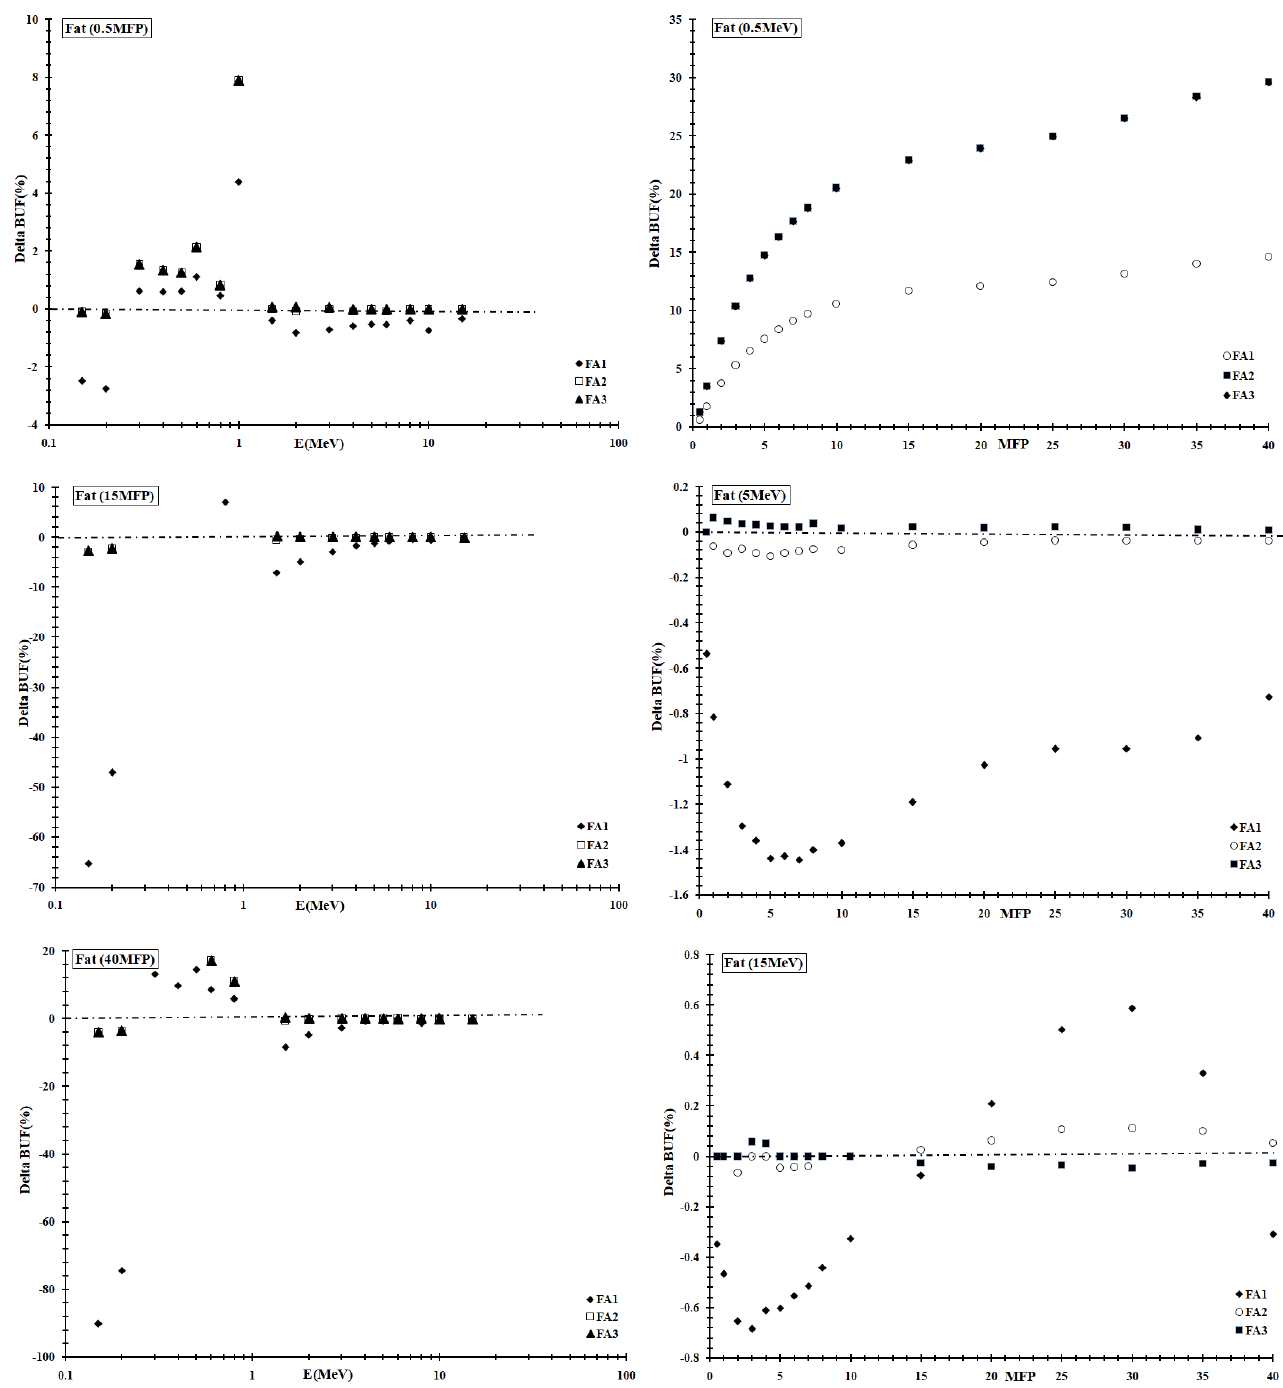
Figure 9. Relative percentage deviation of the BUF values of substitute materials for fat tissue as a function of: ( left side ) photon energy for fixed depths of 0.5, 15 and 40 mfp and ( right side ) depth for fixed photon energies of 0.5, 5 and 15